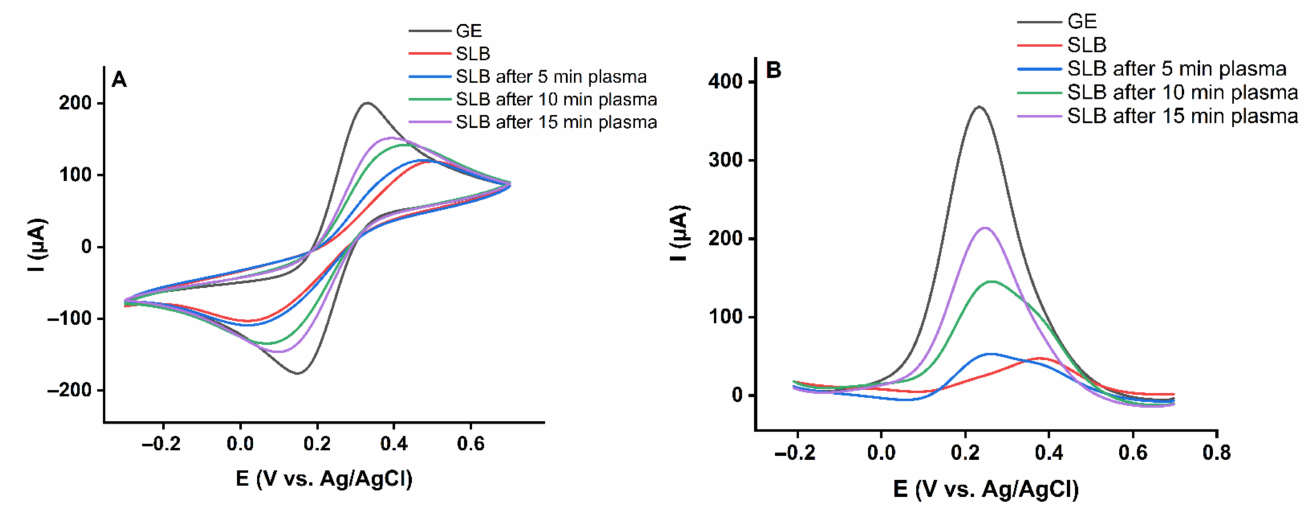
Figure 2. ( A ) Cyclic voltammograms and ( B ) differential pulse voltammograms of 10 mM K 4 [Fe(CN) 6 ] in PBS for the gold electrode (GE) and asymmetric gold supported lipid bilayer (SLB) including 10% cholesterol before and after 5, 10, and 15 min plasma